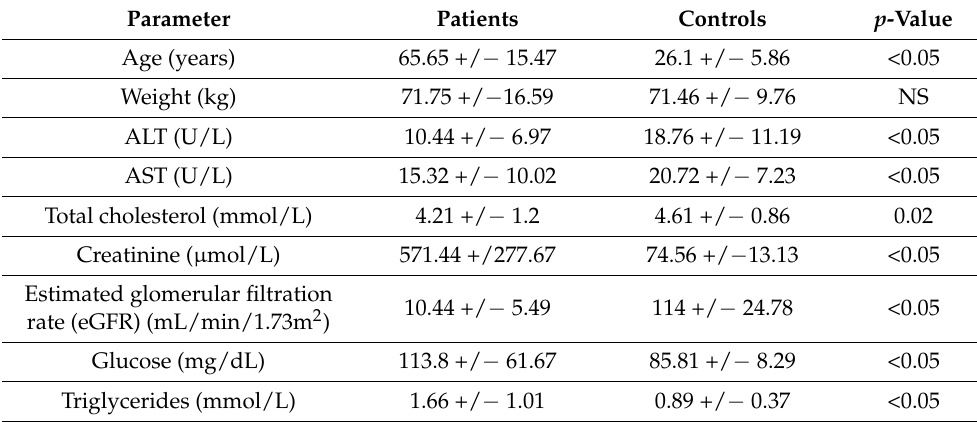
Table 1. Comparison of clinical and biochemical characteristics of study and control groups. Parameter Patients Controls p -Value Age (years) 65.65 +/ − 15.47 26.1 +/ − 5.86 <0.05 Weight (kg) 71.75 +/ − 16.59 71.46 +/ − 9.76 NS ALT (U/L) 10.44 +/ − 6.97 18.76 +/ − 11.19 <0.05 AST (U/L) 15.32 +/ − 10.02 20.72 +/ − 7.23 <0.05 Total cholesterol (mmol/L) 4.21 +/ − 1.2 0.02 Creatinine ( µ mol/L) 571.44 +/277.67 74.56 +/ − 13.13 <0.05 Estimated glomerular filtration 10.44 +/ − 5.49 <0.05 rate (eGFR) (mL/min/1.73m 2 ) Glucose (mg/dL) 113.8 +/ − 61.67 <0.05 Triglycerides (mmol/L)